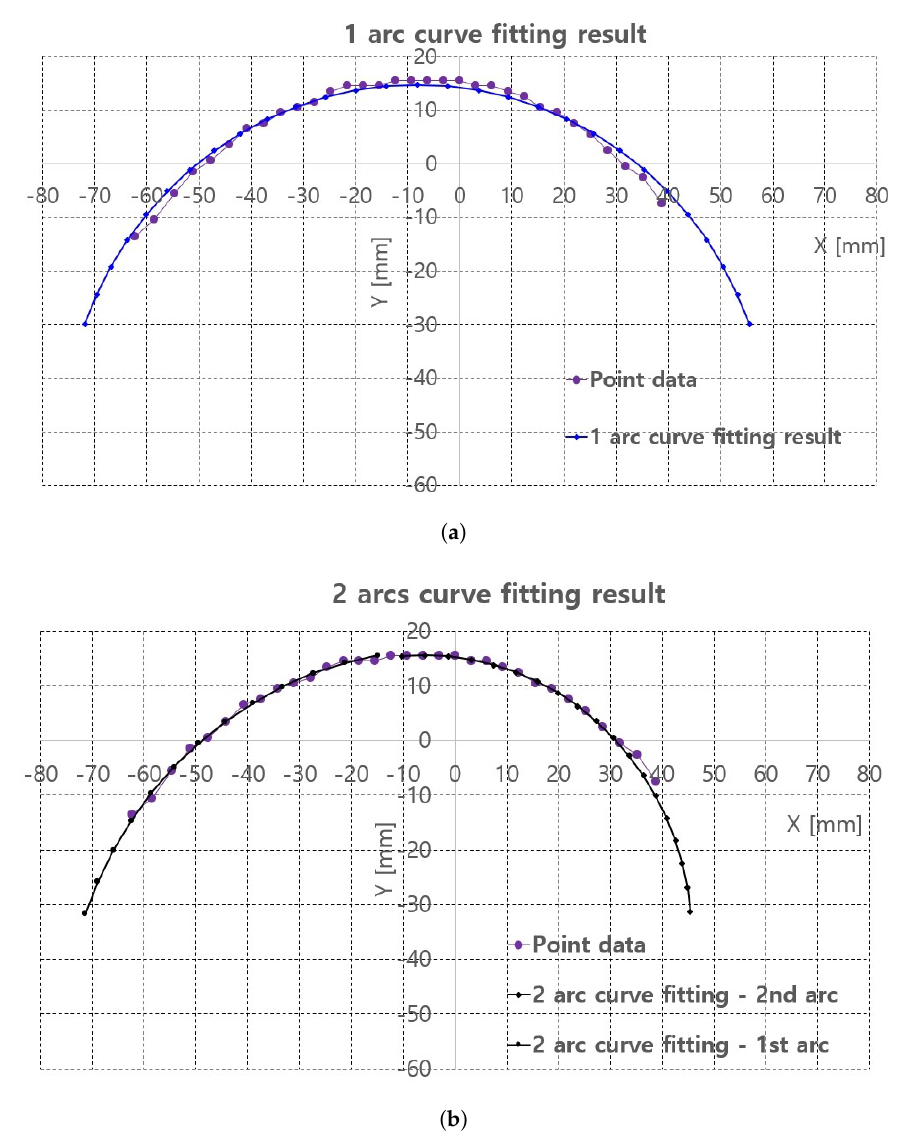
Figure 9. Piecewire curve fitting results of extracted points of back surface of the pig doll. ( a ) 1 arc curve fitting result. ( b ) 2 arc curve fitting